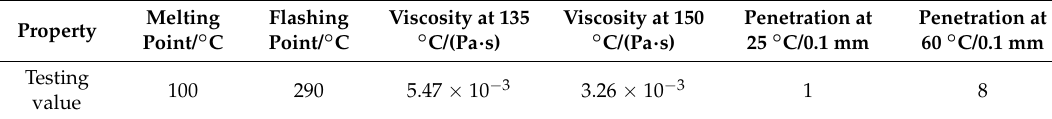
Table 2. Properties of